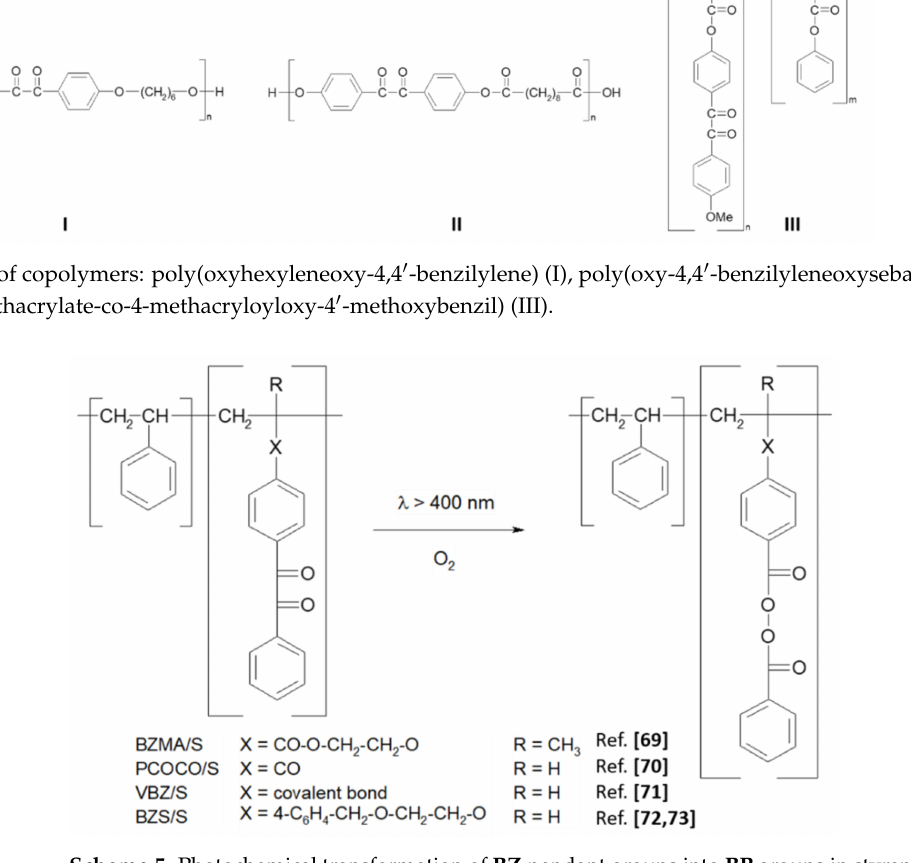
Scheme 5. Photochemical transformation of BZ pendant groups into BP groups in styrene